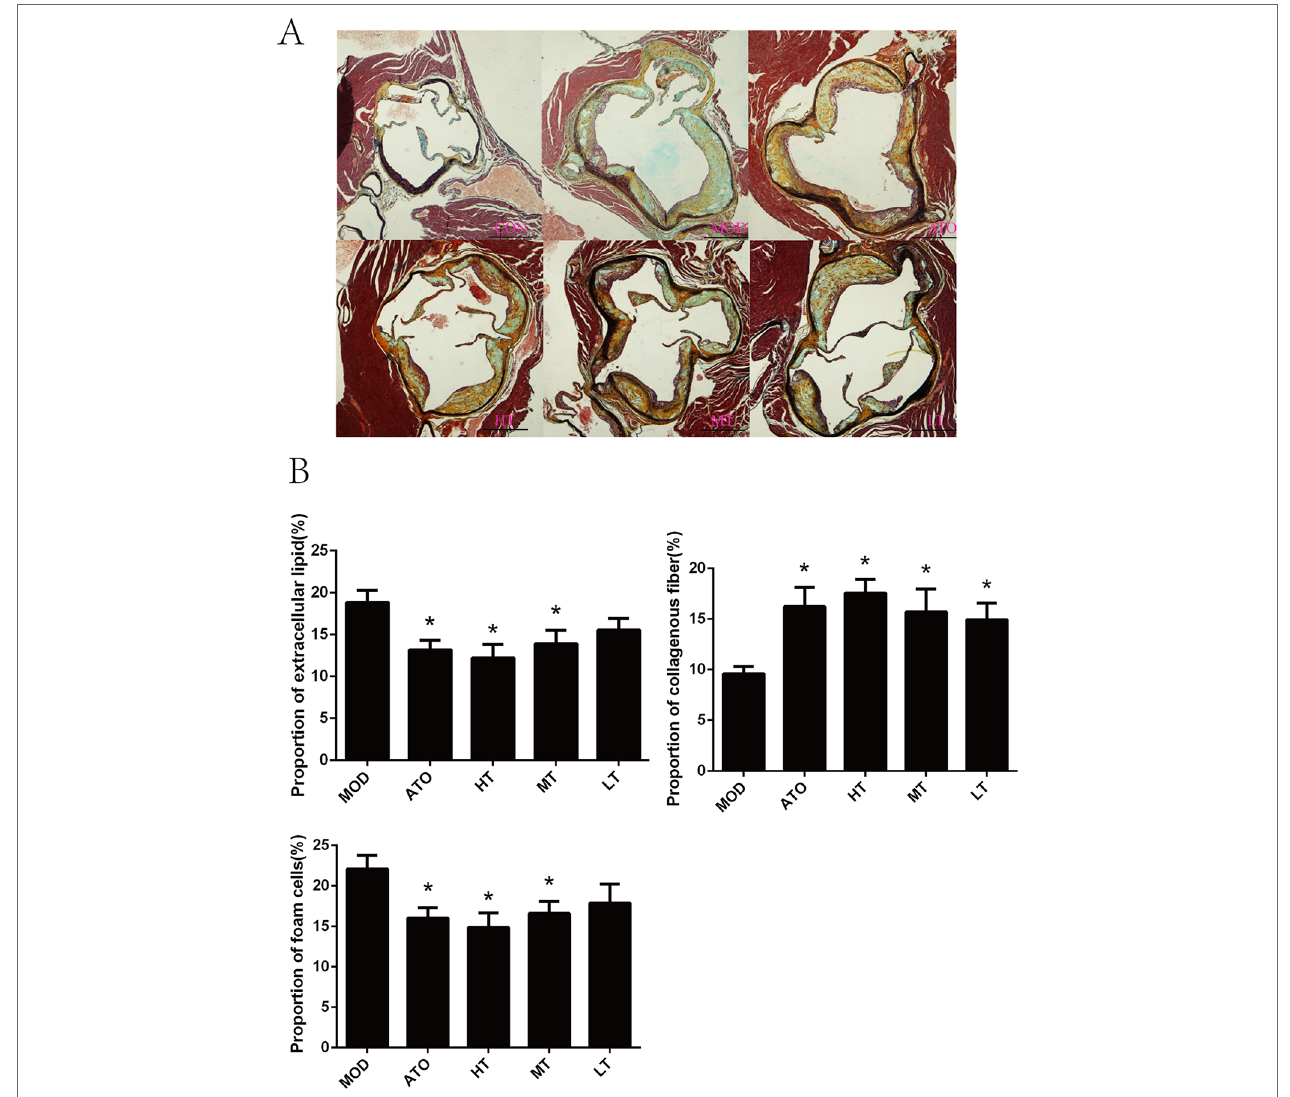
FIGURE 3 | (A) Movat staining of aortic roots and (B) the proportion of extracellular lipid, collagenous fiber and foam cells to plaque. Data are expressed as mean ± SEM. n = 12 (except CON group, n = 9). *P < 0.05 versus MOD group. A: CON, B: MOD, C: ATO, D: HT, E: MT, F: LT (bar = 500